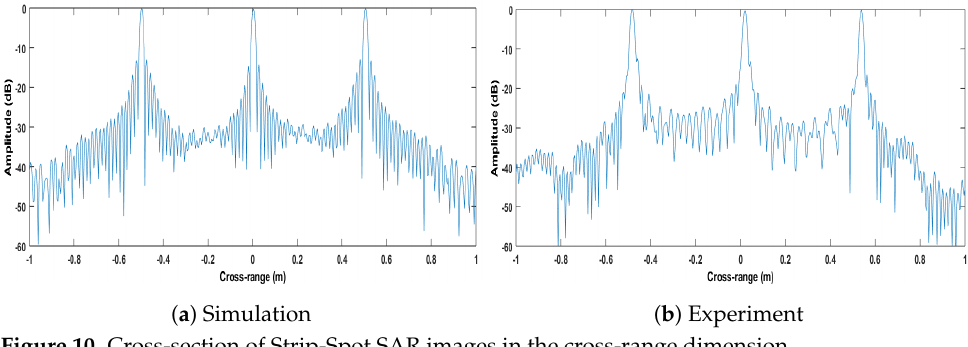
Figure 10. Cross-section of Strip-Spot SAR images in the cross-range dimension. The obtained Strip-Spot resolution is thus in good accordance with that of a Spotlight SAR, as